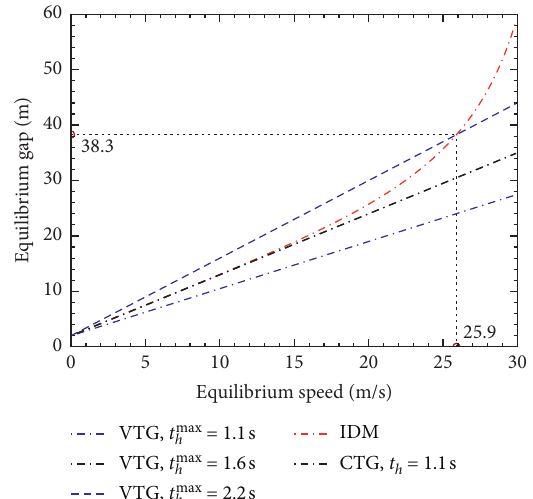
Figure 7: Equilibrium speed-gap relation of IDM and ACC ve- hicles with different desired time gap